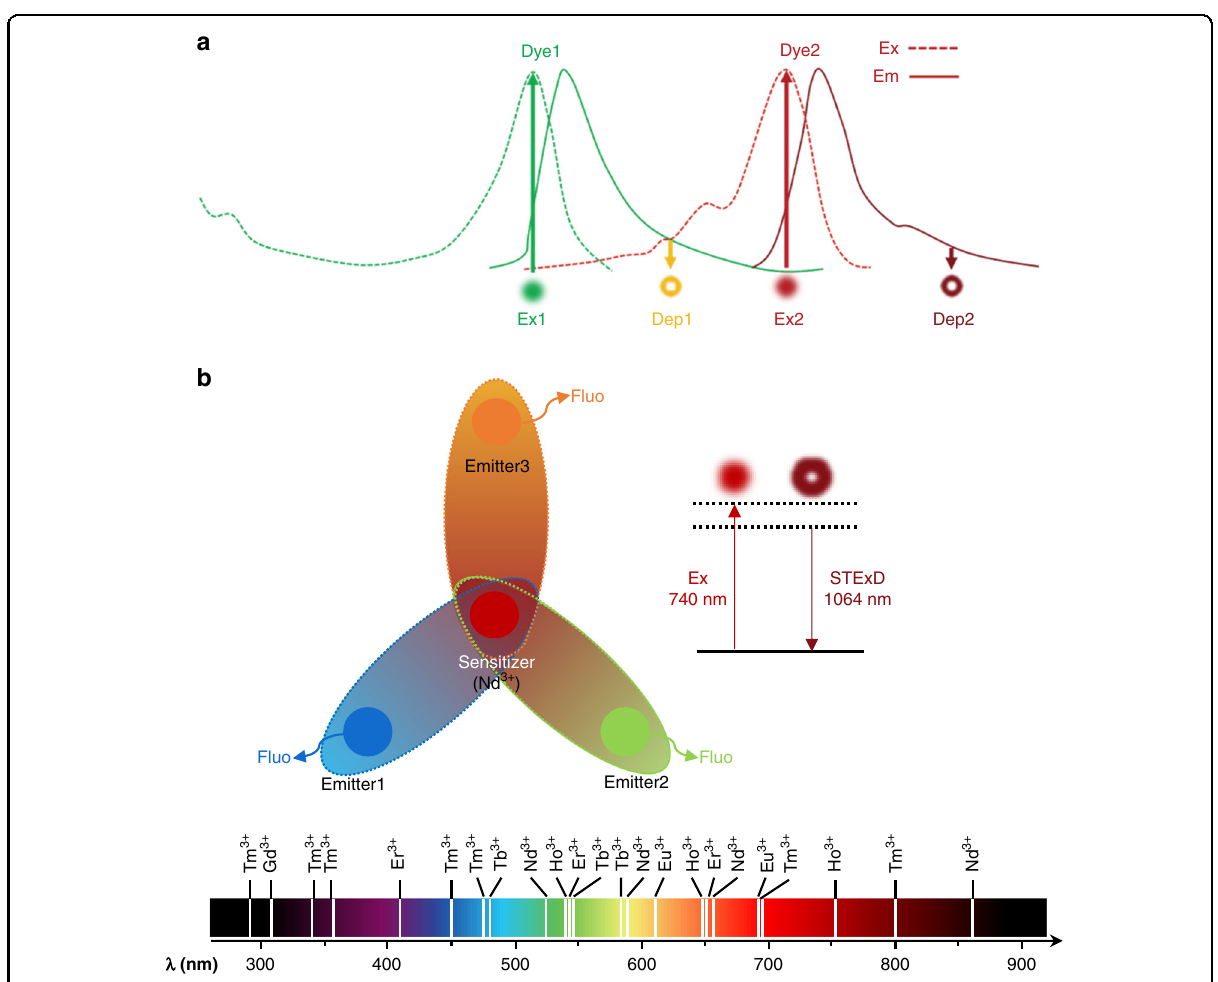
Fig. 1 Schematic diagram of the processes. a The conventional STED, and b the STExD